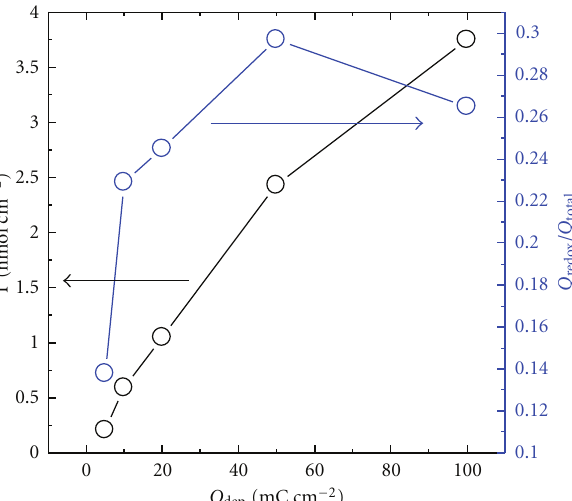
Figure 4: The e ff ect of deposition charge on the redox activity of the PEDOT/LS composite expressed as surface coverage of quinone groups and the ratio of redox peaks charge versus total CV charge. The calculations were made from CV curves recorded at 10mVs − 1 in phosphate bu ff er (pH 7.4).